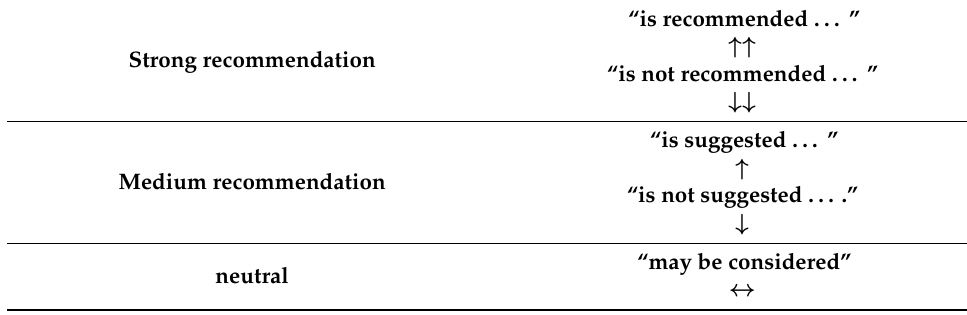
Table 3. LLKardReha-DACH: grades of